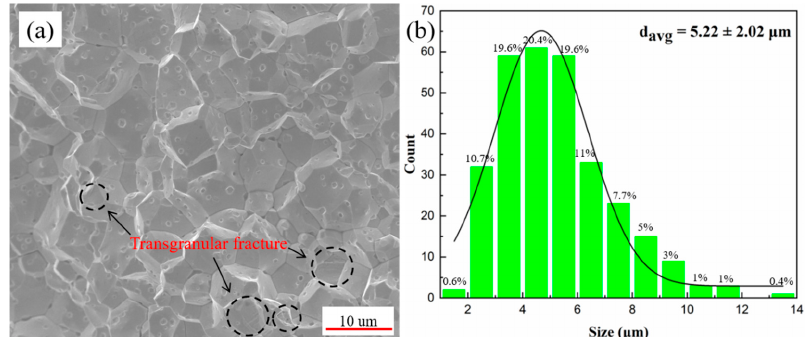
Figure 1. SEM image of fractured surfaces ( a ), and the grain size distributions ( b ) of sintered pure W. Typical hot compressive true stress–strain curves of fine-grained pure tungsten with strain rates of 0.01, 0.1 and 1 s − 1 from 1273 K to 1473 K are shown in Figure 2. It can be seen the flow stress increases rapidly with the increase in strain at the initial stage of hot deformation. This is because the formation of new dislocations at the initial stage of hot compression leads to the increase in dislocation density and the significant work hardening [43,44]. However, with the further increase in strain ( ε > 0.6), the increasing trend of flow stress becomes slow which are attributed to thermal activation softening caused by dislocation rearrangement and annihilation during the compression process [45]. Moreover, the flow stress always showed an increasing trend with the increase in strain, and no obvious peak stress appears when the hot compression temperature is 1273 K as shown in Figure 2a. A similar phenomenon was also observed at hot compression temperatures up to 1373 and 1473 K as shown in Figure 2b,c. Nevertheless, the increasing trend of flow stress becomes gentle, especially, the stress curves tend to a steady stage at low strain rates (0.01 s − 1 ). Therefore, the stress–strain curve can be divided into three stages: (1) the micro-strain stage, where the flow stress increases rapidly under a very small strain and the deformation leads to the rise in dislocation density, which results in work hardening; (2) the uniform deformation stage, where the flow stress continues to increase with the increase in strain; however, the slope of the stress–strain curve gradually decreases, and the softening effect offends part of the work hardening effect; (3) the steady flow stage, where the flow stress no longer increases with the increase in strain and remains in a horizontal state, and there is a constant stress. In this case, the softening effect completely cancels the work hardening caused by deformation, i.e., the rate of increase in dislocation density and that of annihilation of dislocations reaches equilibrium [46]. Thus, the dynamic equilibrium of work softening and work hardening is obtained [47]. The micro-strain stage and the uniform deformation stage were usually observed under all circumstances as shown in Figure 2a–c; however, the steady flow stage was most obviously observed only when the deformation temperature is high and strain rate is low (T = 1473 K and 𝜀(cid:4662) =0.01 s − 1 ), as shown in Figure 2c, which is due to the small range of temperature and strain rate selected in the hot compression test. Nevertheless, in relevant studies [48,49], the true stress strain curve usually shows a partial drop area, wherein there is a continuous decrease in flow stress with the increase in deformation temperature. In addition, a stress peak is observed, which is related to dynamic recrystallization (DRX). Moreover, no peak of flow stress was formed in the stress–strain curve of this work, which is related to dynamic recovery (DRV) [50]. The dynamic recovery will increase with the increase in applied strain, and lead to the enhancement of softening effect. But softening rate caused by DRV is lower than work hardening rate which leads to the continuous increase in flow stress. As the strain continues to increase, the softening effect induced by